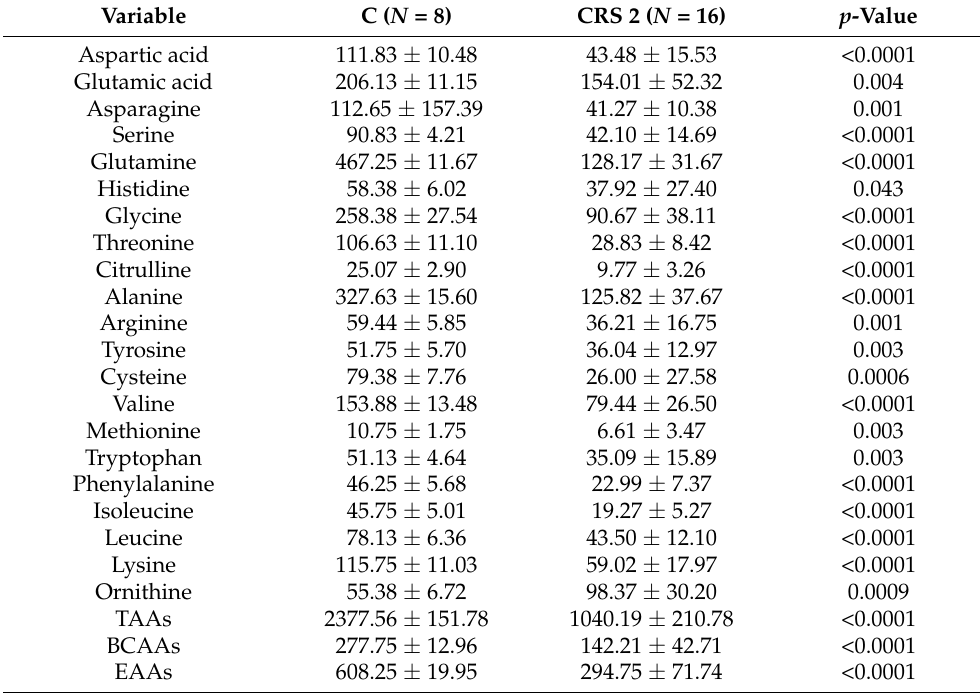
Table 3. Plasma venous AA concentrations ( µ mol/L) in controls (C) and cardiorenal syndrome type 2 (CRS 2) patients.